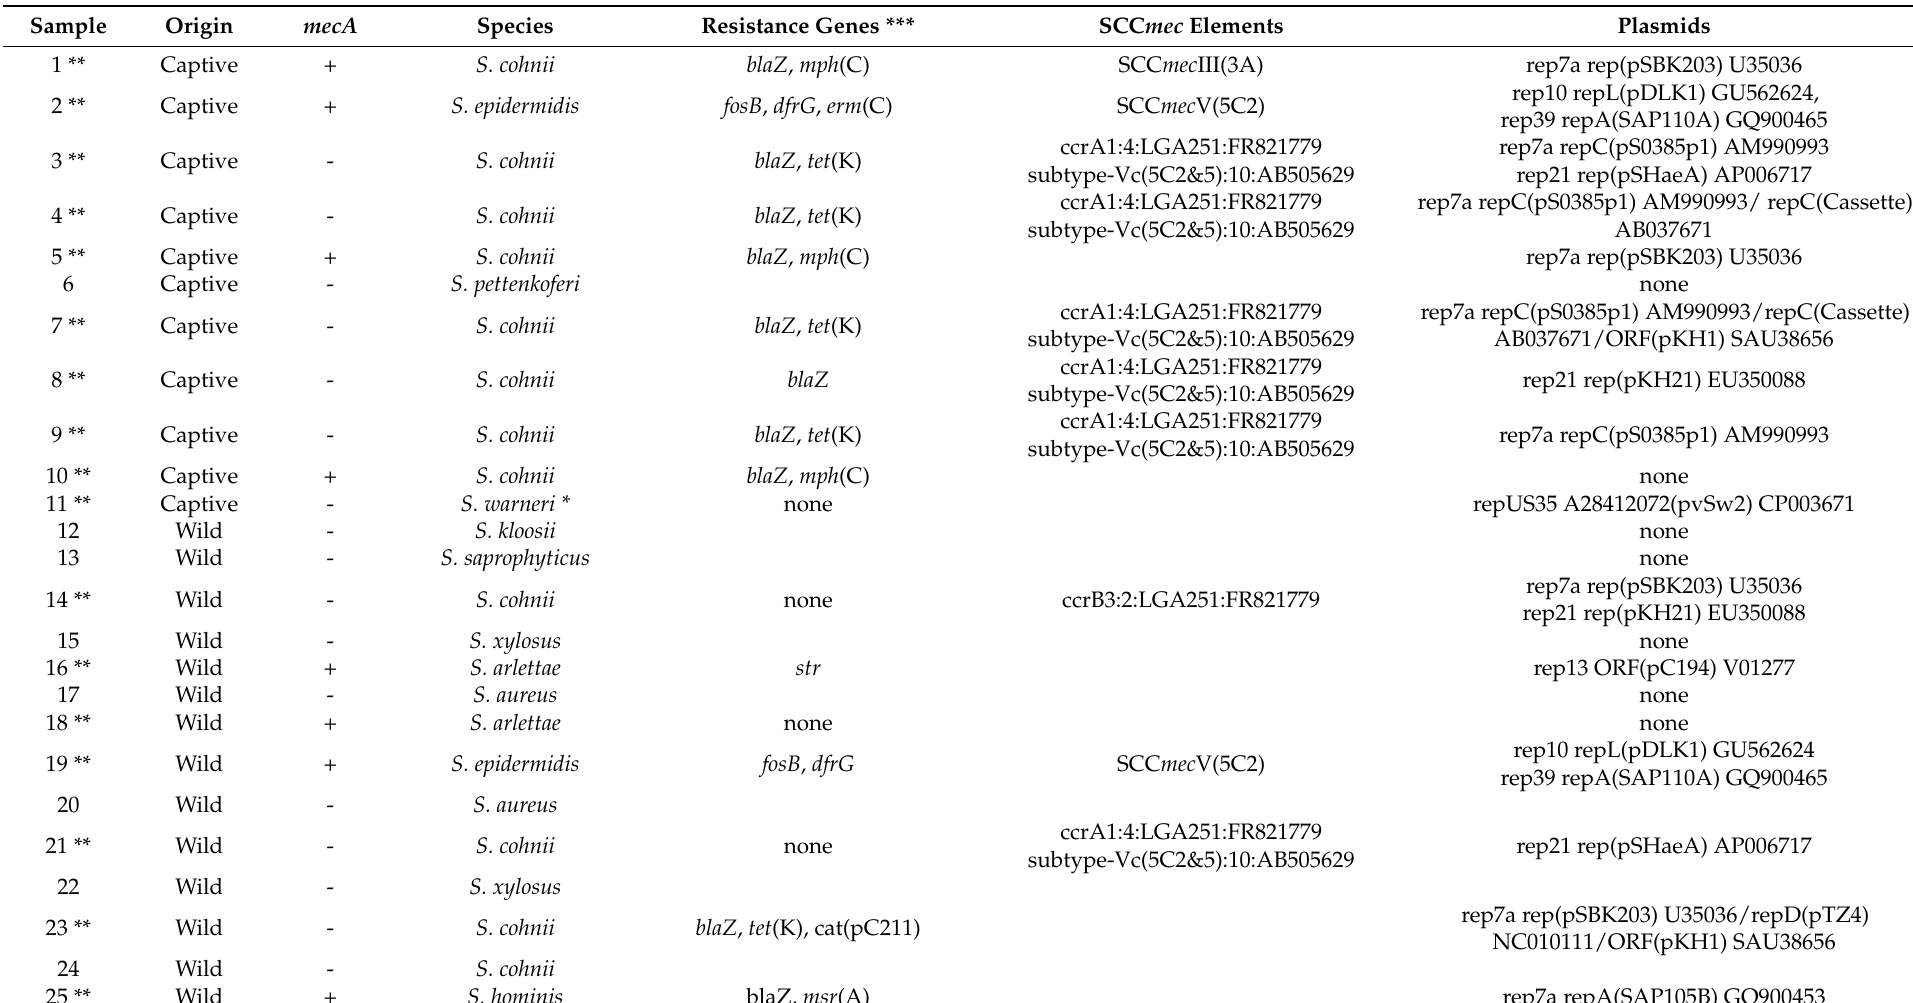
Table 1. Isolation results of the samples and DNA analysis of the